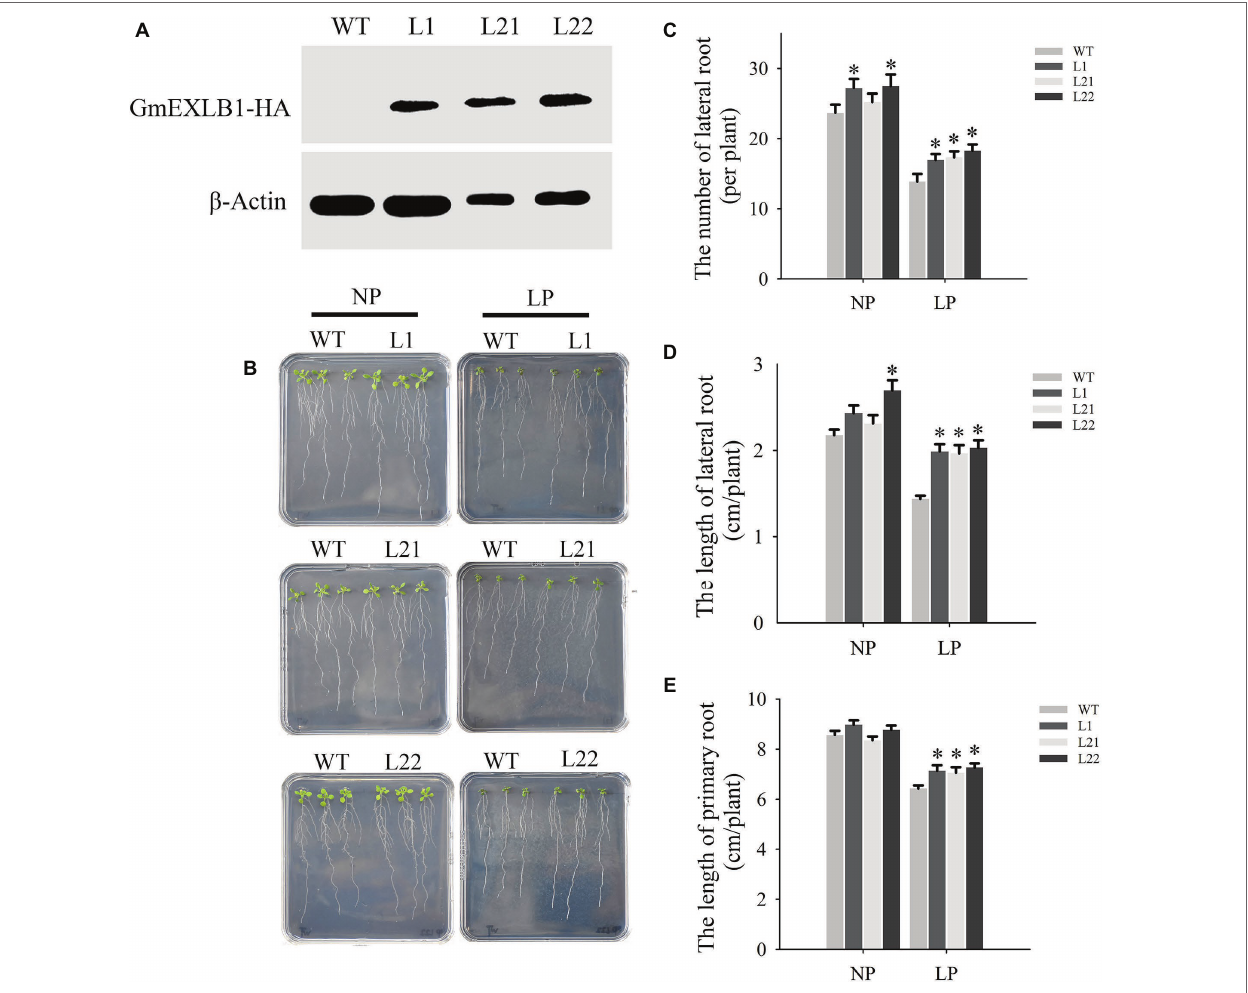
FIGURE 7 | Root phenotypic analysis of transgenic Arabidopsis with GmEXLB1 overexpression. (A) Western blotting of transgenic and wild-type plants. WT: wild-type plant. L1, L21, and L22: three transgenic lines. (B) Root phenotype observed on agar with NP and LP. (C) The number of lateral roots in transgenic and wild-type plants under NP and LP conditions. The data are the mean ± SE ( n = 5). Error bars represent the SE. Asterisks indicate that the values are significantly different ( p < 0.05). (D) The lateral root lengths in transgenic and wild-type plants under NP and LP conditions. The data are the mean ± SE ( n = 5). Error bars represent the SE. Asterisks indicate that the values are significantly different ( p < 0.05). (E) The primary root length in transgenic and wild-type plants under NP and LP conditions. The data are the mean ± SE ( n = 5). Error bars represent the SE. Asterisks indicate that the values are significantly different ( p <